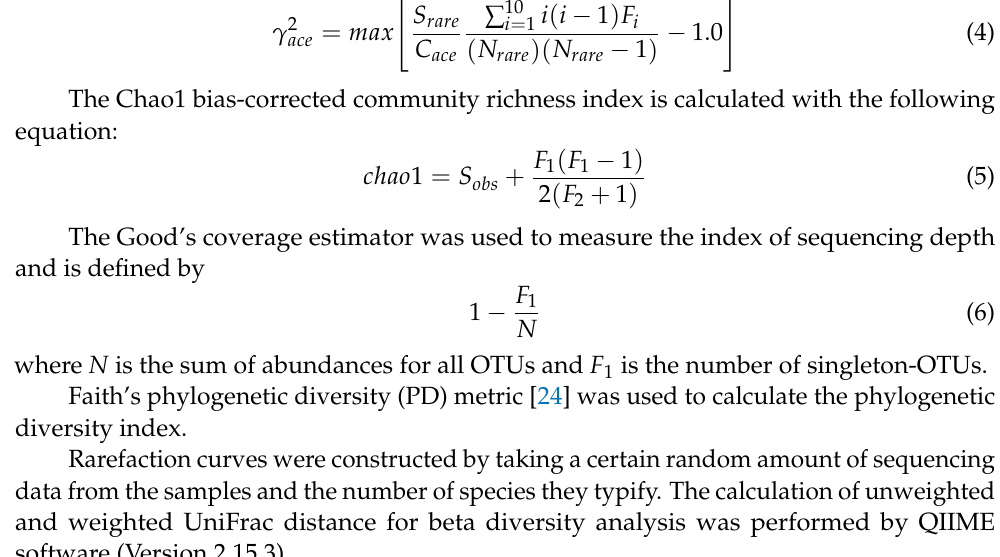
Figure 2. Rarefaction curves of the three extremely halophilic microbial samples displaying the ob- served species number compared to the observed OTUs at a certain depth of sequencing. Table 1. Alpha diversity indices. Sample Name